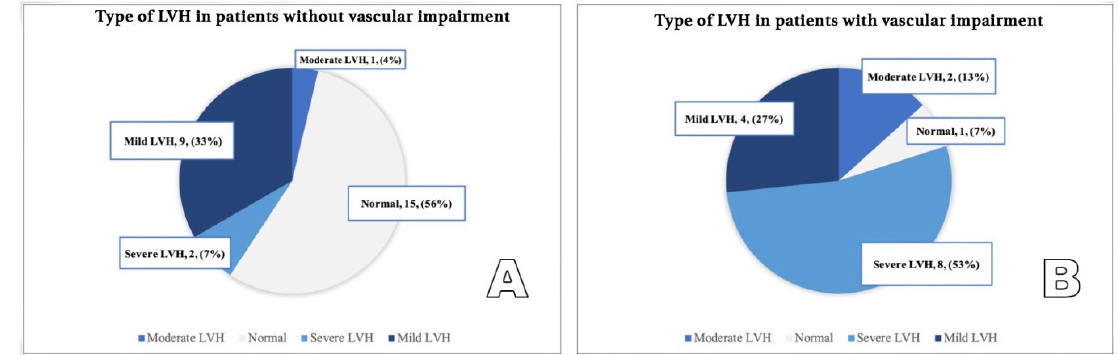
Figure 8. ( A , B ) Severity of LVH in patients without vascular impairment ( A ) compared to patients with vascular impairment ( B ).